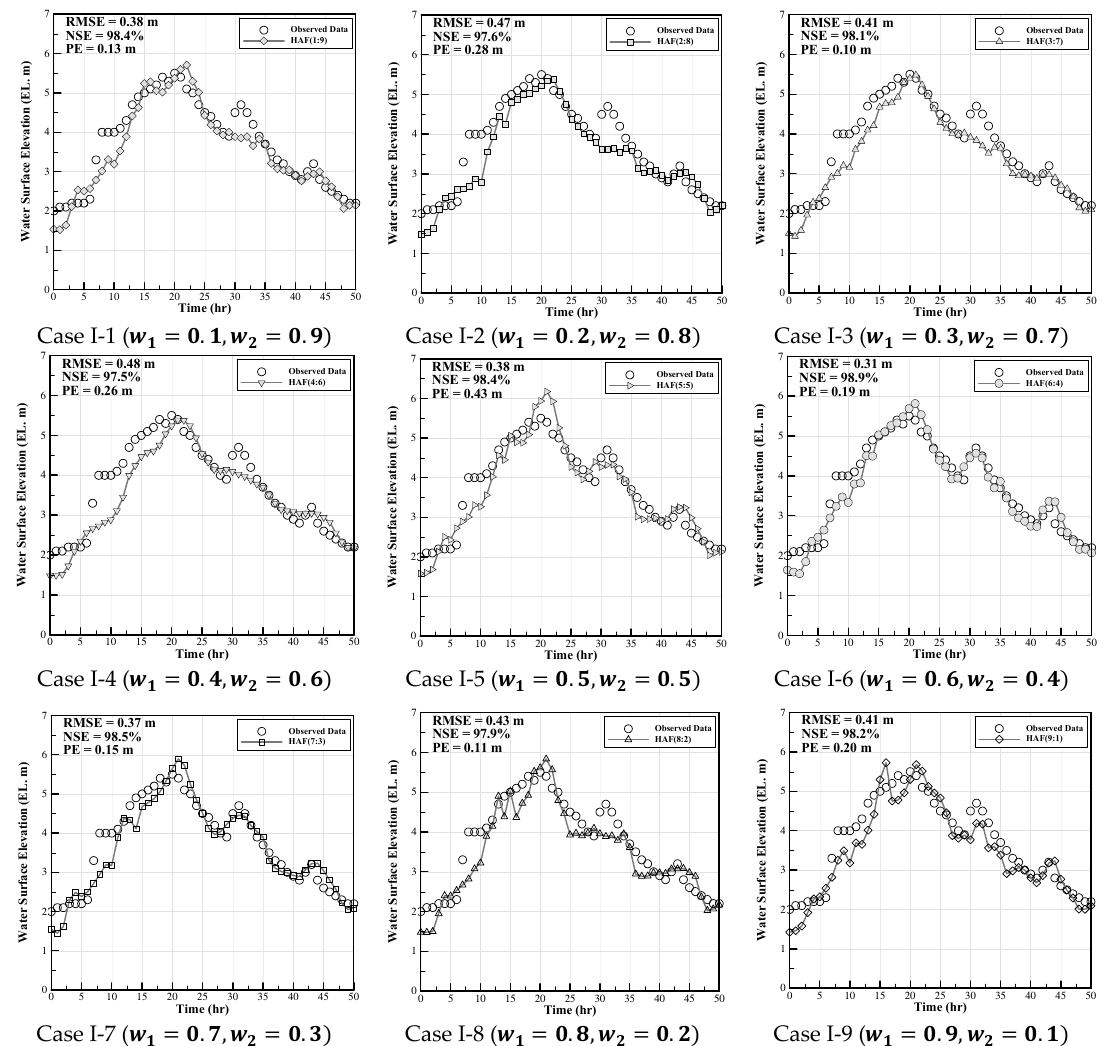
Figure 5. Results of the flood forecasting model in Scenario Ι . Table 7. Summary of accuracy for various weights in Scenario Ι (Period: 5–7 July 2016, about 50 h).